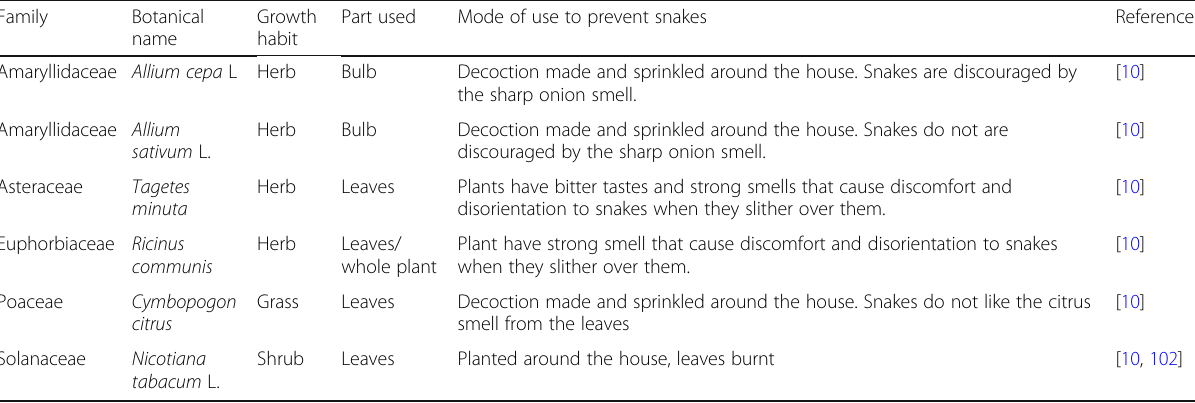
Table 2 Plants used in Ugandan rural communities for repelling of snakes